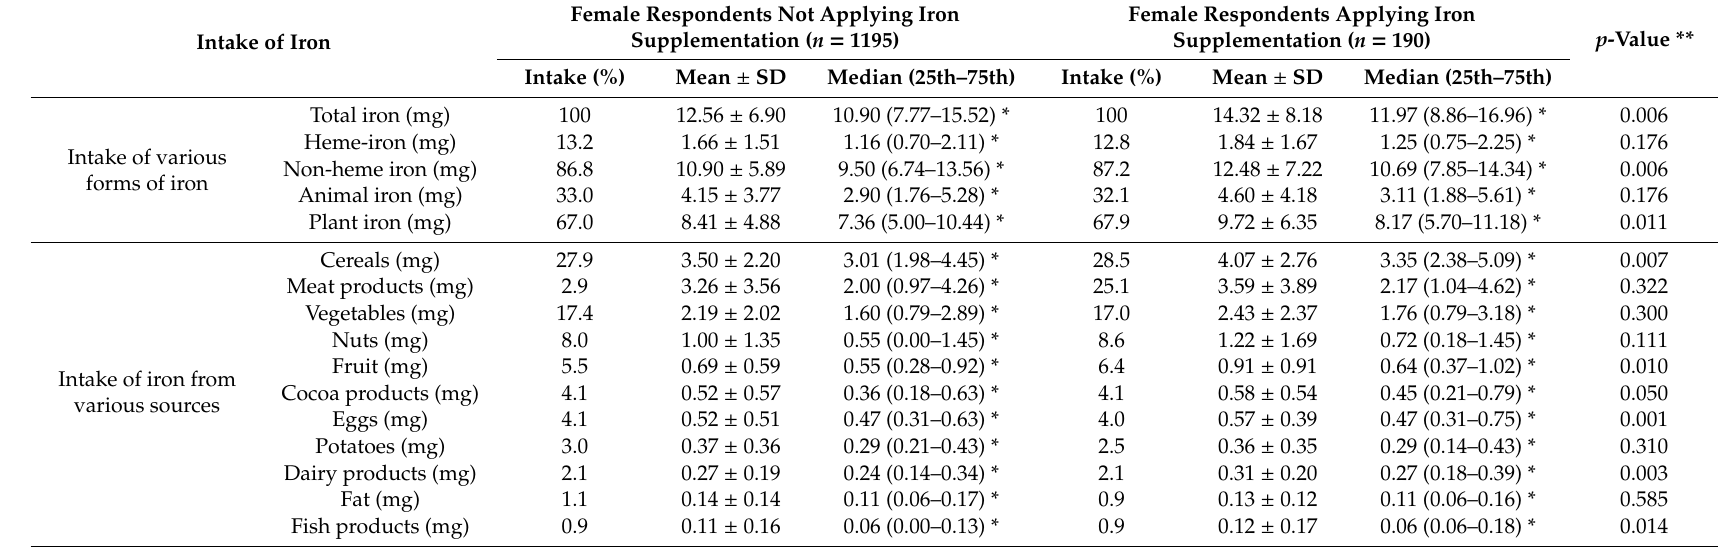
Table 7. Comparison of the intake of various forms of iron along with that of iron intake from various sources in the national sample of Polish female adolescents, in the sub-groups of female respondents not applying and applying iron